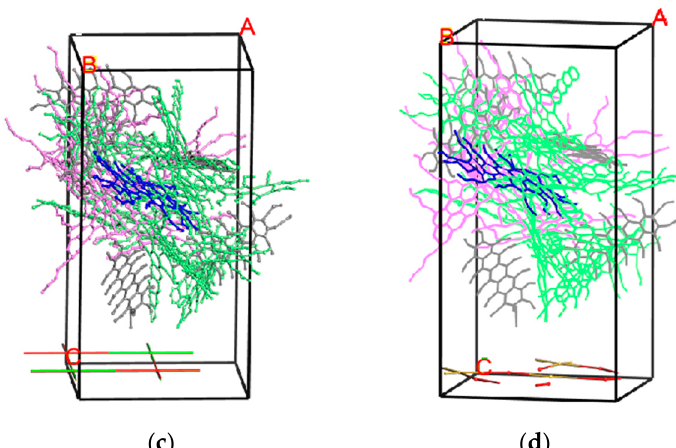
Figure 1. The interfacial models of the asphalt-binder-mineral bond: ( a ) asphalt binder (blue represents aromatics; grey represents saturates; green are asphaltenes; and purple are resins); ( b ). asphalt-binder-Al 2 O 3 ; ( c ) asphalt-binder- SiO 2 ; ( d ) asphalt-binder- CaO.